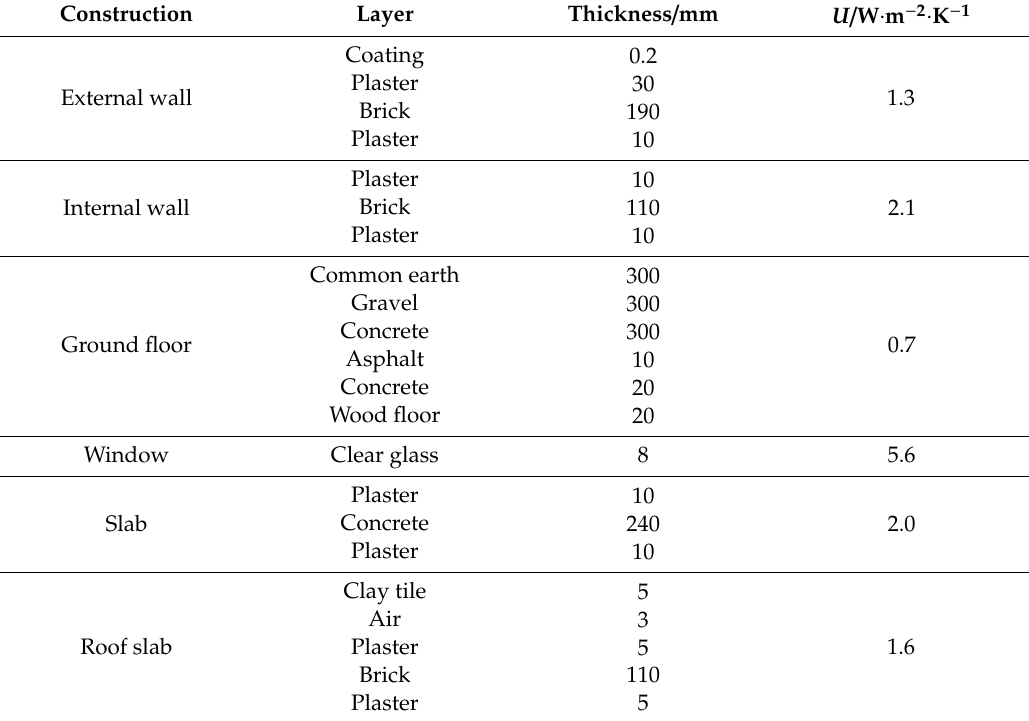
Table 1. Construction details of the building with a single wall façade